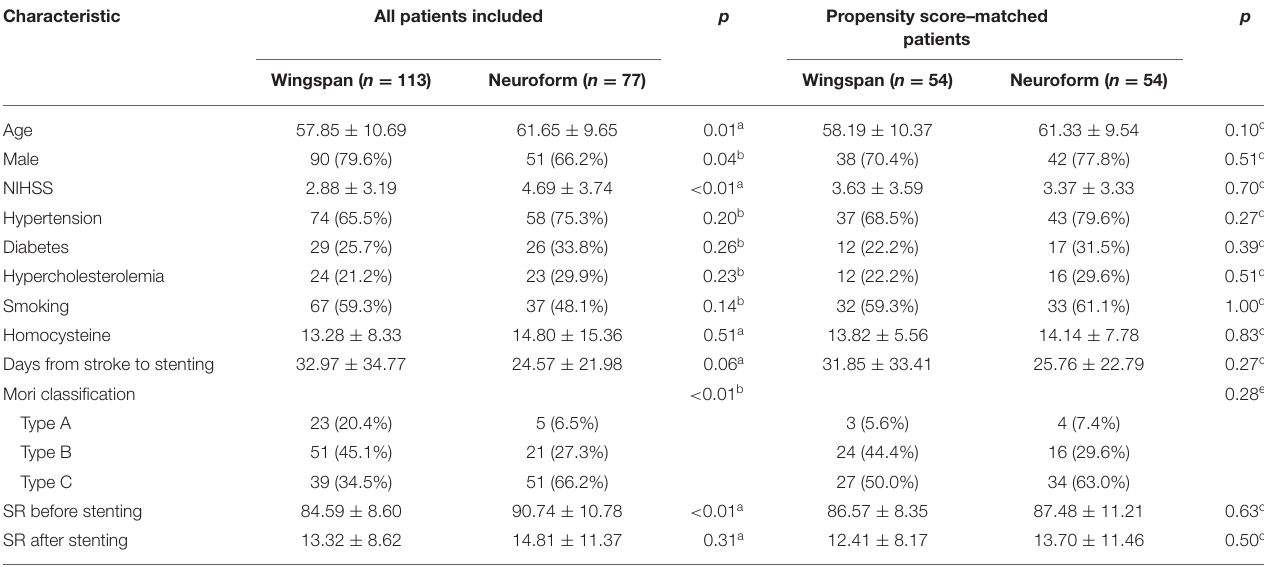
TABLE 1 | Baseline characteristic of the patients.